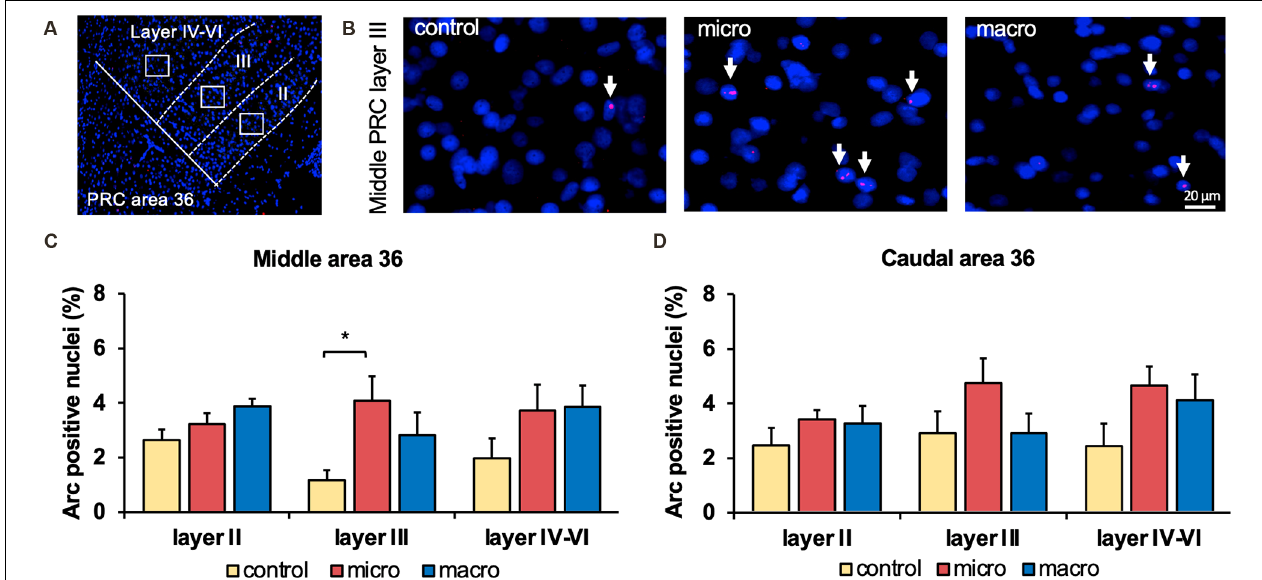
FIGURE 3 | Neurons in layer III of area 36 respond to learning about microscale items. (A) Representative DAPI-stained coronal sections of the rat brain showing PRC area 36 and its layer organization (separated by white dotted lines). White squares indicate the origin of the representative photomicrographs. (B) Photomicrographs showing nuclear Arc mRNA expression (red, indicated by white arrows) in layer III of the middle area 36 of control animals (control) or animals that participated in microscale (micro) or macroscale (macro) item exploration. Blue: nuclear staining with DAPI. Images were taken using a 20x objective. Scale bar: 20 µ m. (C,D) In the middle area 36 exposure to microscale items (micro) but not macroscale items (macro) triggers a significant increase in Arc mRNA expression in layer III compared to controls ( Post hoc test: layer III: middle control vs. micro p < 0.05, caudal control vs. micro p = 0.079281). No changes in Arc mRNA expression were observed in layer II or layers IV-VI of the middle and caudal area 36. The relative percentage of Arc mRNA positive nuclei in the middle (C) and caudal (D) area 36 of the control and the two experimental groups (mean ± SEM). (C,D) Significant differences for each layer for the experimental groups compared to their control group are marked with an asterisk * p <